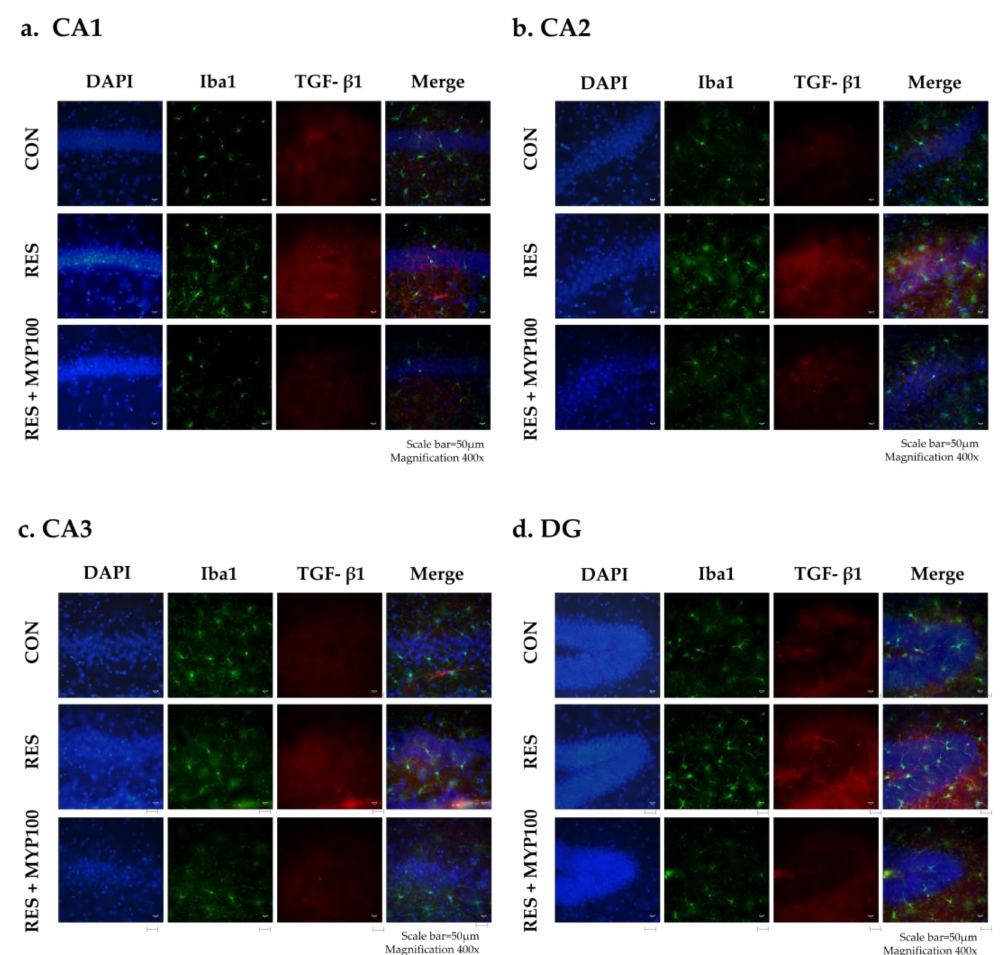
Figure 10. The regulation of TGF- β 1 and Iba1 expression by myelophil (MYP) treatment in the hippocampus. ( a – d ) DAPI- (blue), TGF- β 1- (red), and Iba1- (green) positive cells were observed in cornu ammonis area (CA) 1, CA2, CA3, and dentate gyrus (DG) of the hippocampus. TGF- β 1- and Iba1-positive cells were reduced in all hippocampus regions following MYP treatment. Photomicrographs were captured at a magnification of 400 × (Scale bar = 50 µ m). CON: control, RES: treatment with 2 mg/kg reserpine, RES + MYP100: treatment with 2 mg/kg reserpine followed by 100 mg/kg